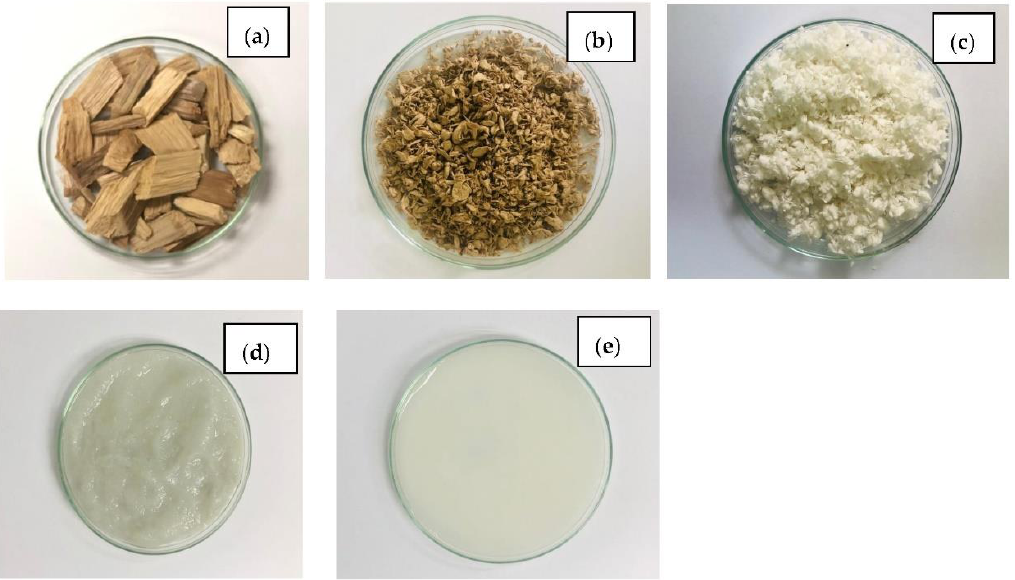
Figure 3. Conversion of Macaranga gigantea to NCC and NFC illustrating each step involving ( a ) wood chips, ( b ) unbleached pulp, ( c ) bleached pulp, ( d ) NFC, and ( e ) NCC.